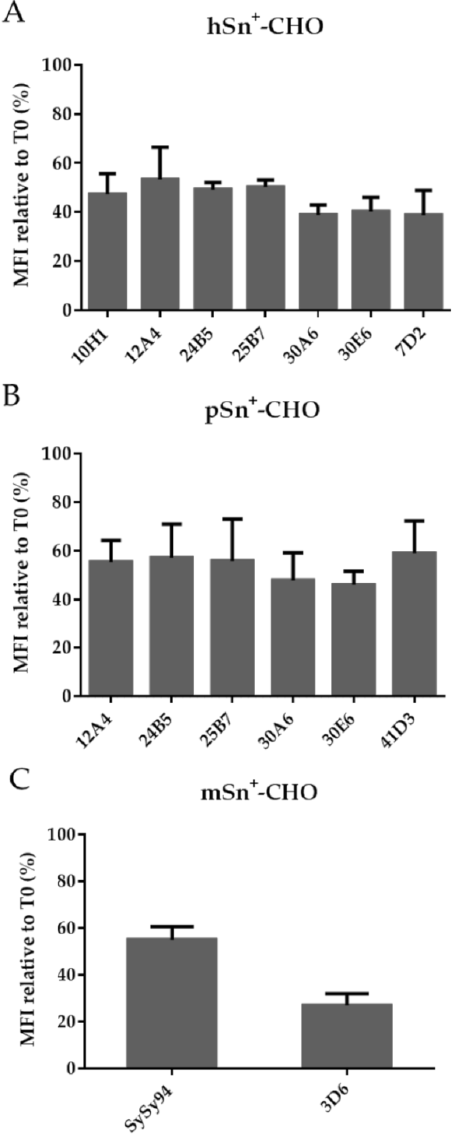
Figure 7. Flow cytometric analysis of internalization capacity of different mAbs on Sn + -CHO cells. The cells were incubated with different mAbs to allow only binding to surface-expressed ( A ) hSn; ( B ) pSn; and ( C ) mSn. Afterwards the cells were shifted to 37 °C during 60 min to induce internalization of Sn. Secondary fluorescently-labeled antibodies were added to the cells, staining only remaining surface-Sn. Only viable cells were analyzed with flow cytometry using PI staining. Data represent the mean and standard error of the mean of three independent repeats. Relative internalization was calculated by comparing the fluorescent signal to that of cells without internalization.